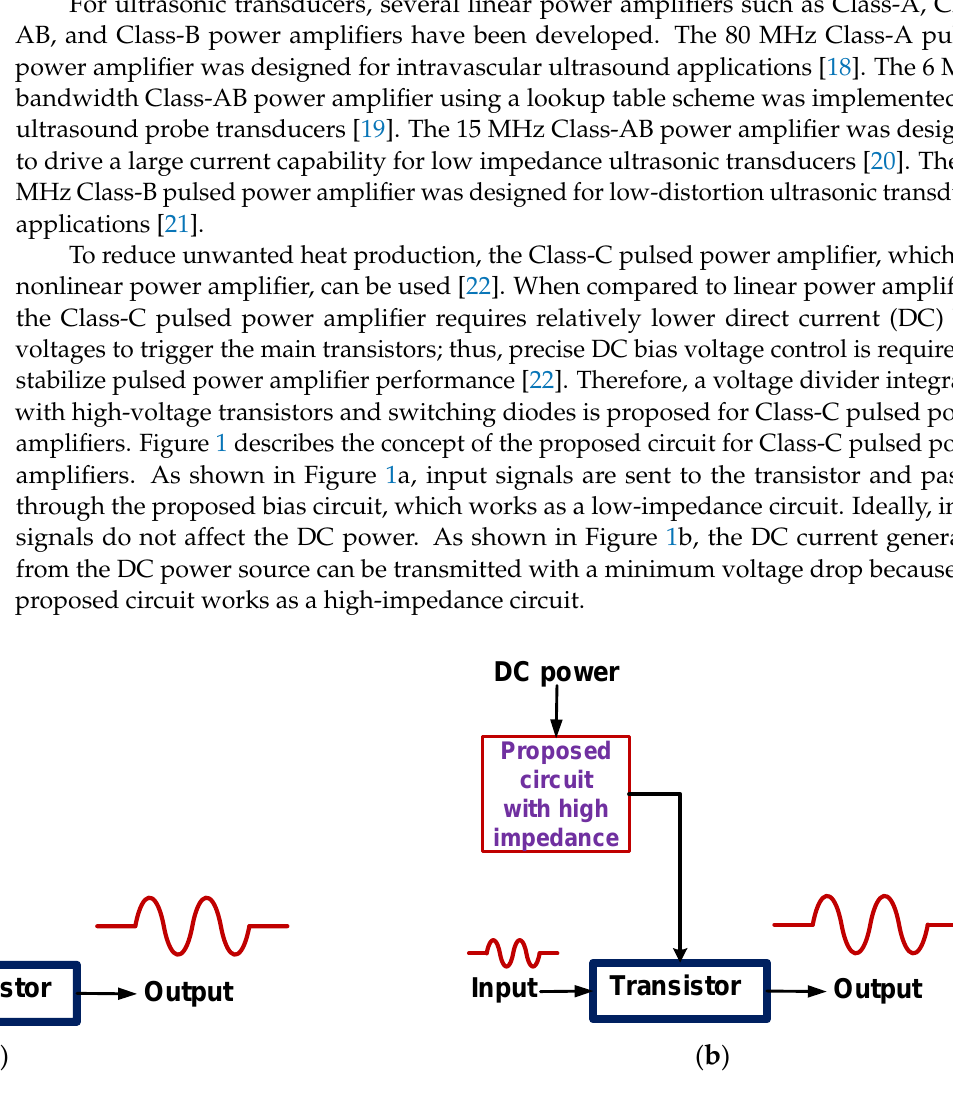
Figure 1. Concept of novel Class-C pulsed power amplifier structures. Signal paths when ( a ) input signals were blocked in the bias circuit and ( b ) DC current was provided to the transistor.